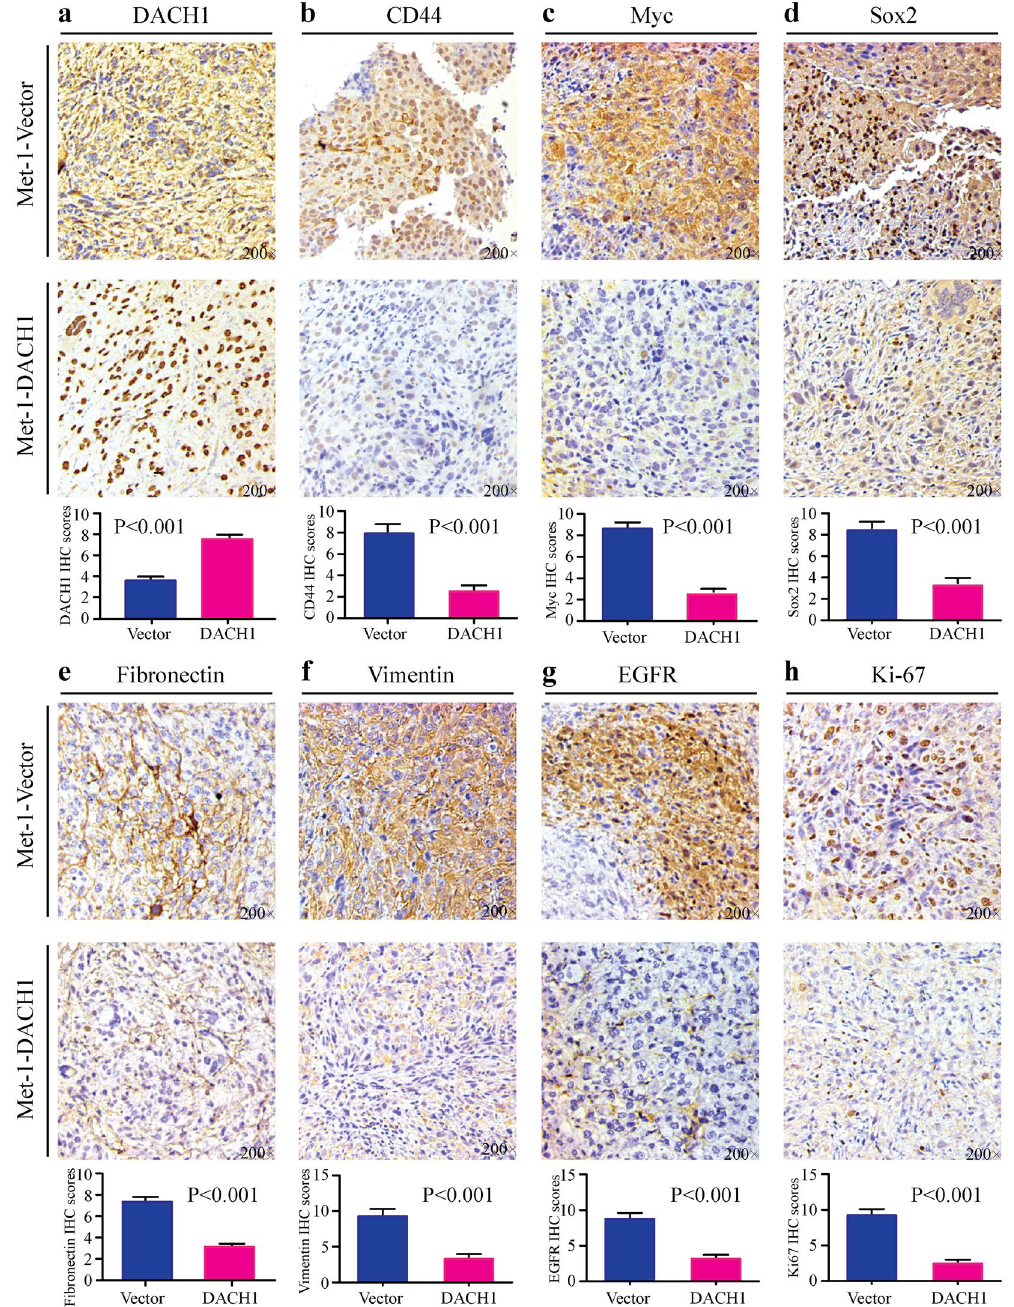
Figure 4. DACH1 reduced the expression of CD44, Myc, Sox2, Fibronectin, Vimentin, EGFR and Ki-67 in vivo . Both representative immunohistochemistry images and scoring results showed that overexpression of DACH1 ( a ) down-regulated the protein abundance of CD44 ( b ), Myc ( c ), Sox2 ( d ), Fibronectin ( e ), Vimentin ( f ), EGFR ( g ) and Ki-67 ( h ) in nude mice xenograft